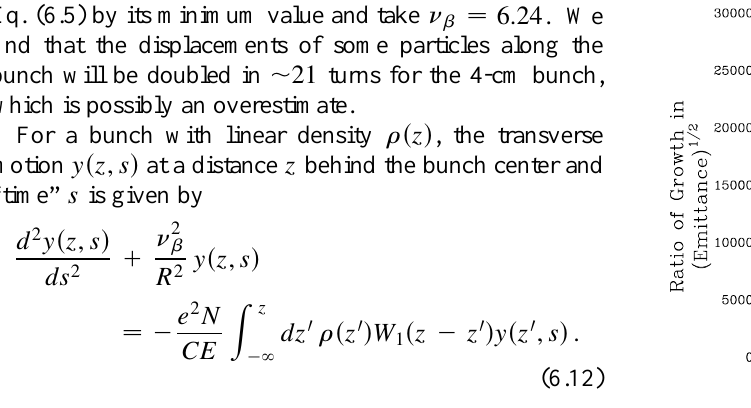
FIG. 16. Beam-breakup growth of the 4-cm bunch interacting with a broadband impedance of Q (cid:1) 1 , Z (cid:1) (cid:1) 0.1 M V (cid:1) m at the angular resonant frequency of v r (cid:1) 50 GHz. The total growths at 1000 turns reach 29 713, 3361, 287, and 16.2, respectively, for (cid:8) b (cid:9) (cid:1) 25 , 20, 15, and 10